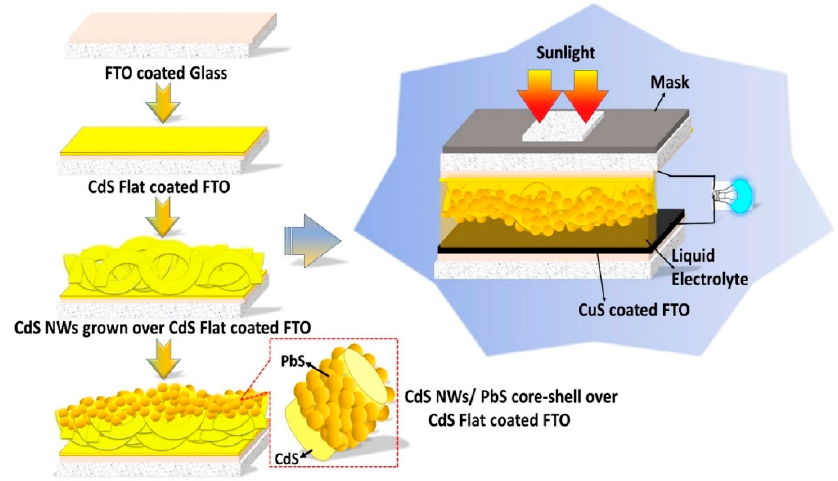
Figure 9. Production process of CdS nanowires on FTO (fluorine-doped tin oxide) glass, SILAR deposition of PbS nanoparticles and final solar cell assembly. From [87], reprinted with permission. Copyright © Elsevier 2019.